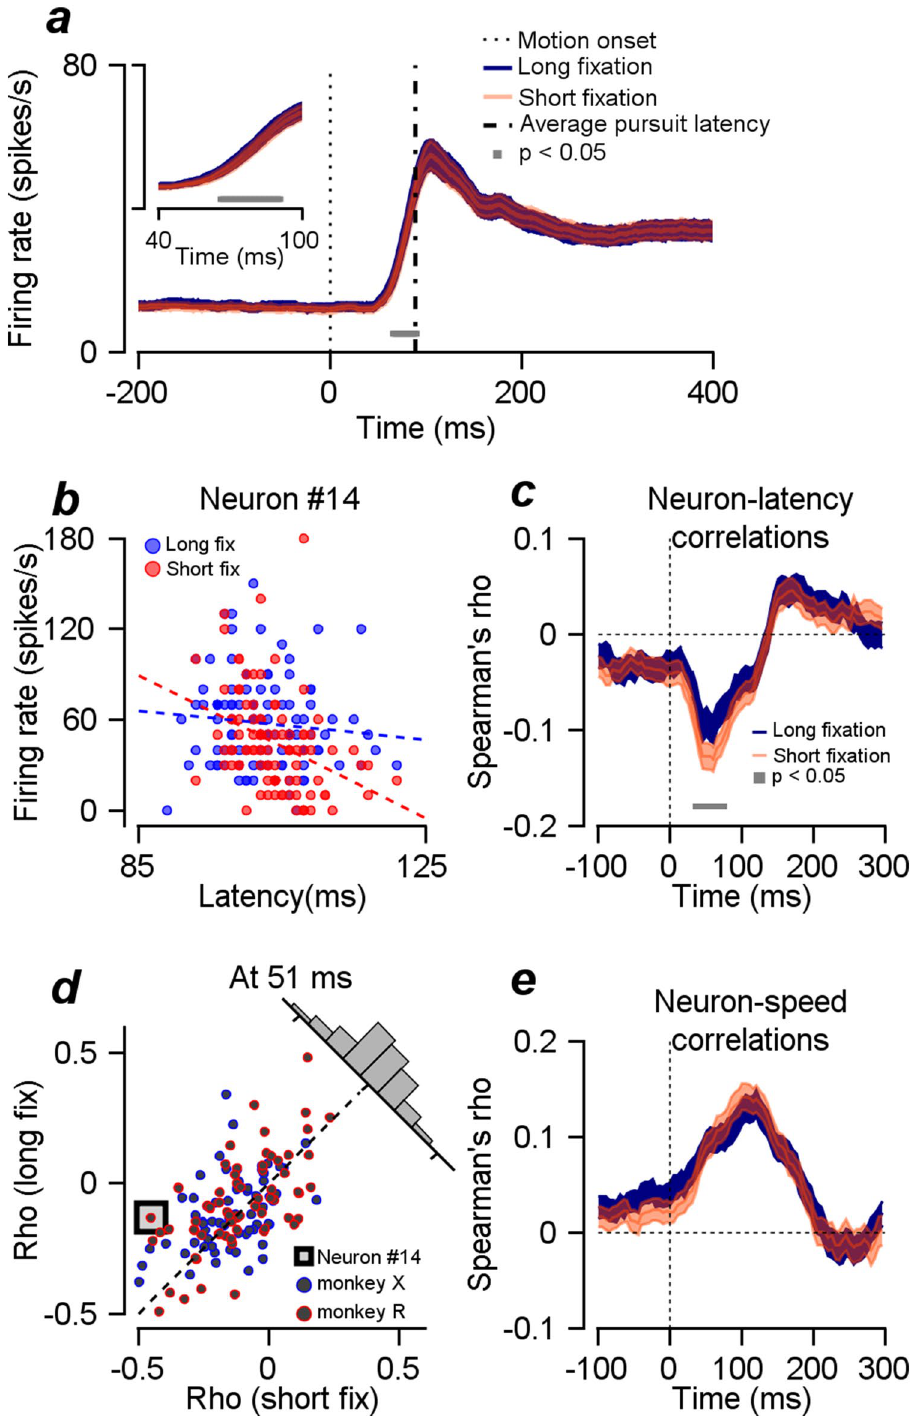
Figure 2. Effects of temporal expectation on FEF SEM neural activities. ( a ) Effect of temporal expectation on the average PSTH of 133 neurons. The inset is a time-magnified figure. The gray bar shows the time points where PSTHs between the two conditions were significantly different from each other. The black dotted line shows the pursuit target onset timing, and the dash-dotted line shows the average pursuit latency. ( b ) A scatter plot of an example neural activity (neuron #14) showing the relationship between the pursuit latency and neural responses measured at 1~100 ms from motion onset. The trials were divided into two groups, one with a short fixation duration (fixation duration < 1500 ms) and the other with a long fixation duration (fixation duration > 1500 ms). ( c ) Average neuron-pursuit latency correlations for the two fixation duration conditions for 130 neurons as a function of time. The gray bar shows the time points of statistical significance. ( d ) A scatter plot of neuron-pursuit latency correlations comparing the two fixation duration conditions measured at 51 ms (a time window of 1~100 ms). The red contoured circles are from monkey R, and the blue contoured circles are from monkey X. The black contoured square shows the result of the example neuron. The inset histogram shows the distribution of correlation differences (short fixation duration–long fixation duration). ( e ) Average neuron-pursuit speed correlation for the two fixation duration conditions as a function of